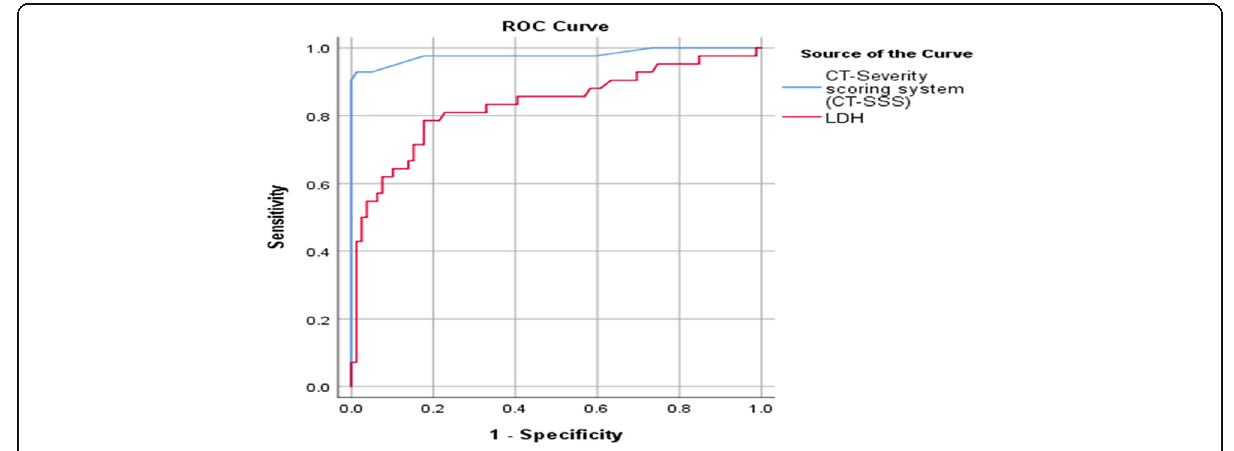
Fig. 6 ROC curve for severe cases using CT-SSS and